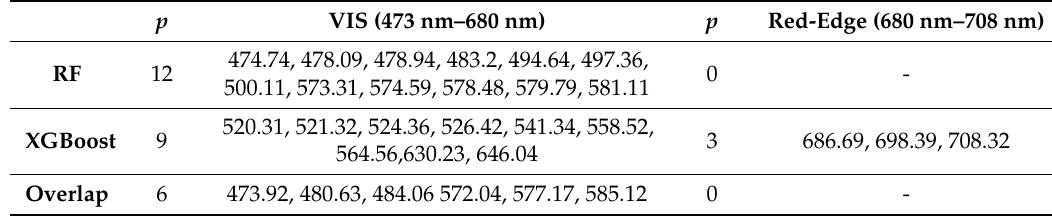
Table 3. Classification accuracies of both the RF and XGBoost models constructed using all the wavebands and the subset of important wavebands.